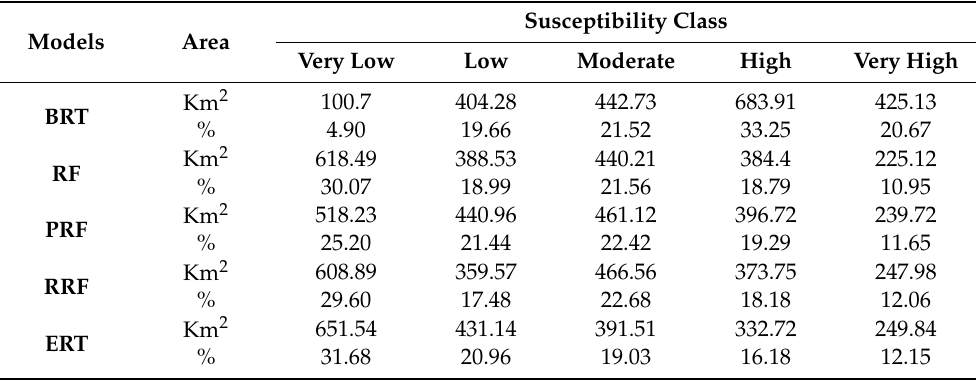
Table 2. Flash flood susceptibility classes’